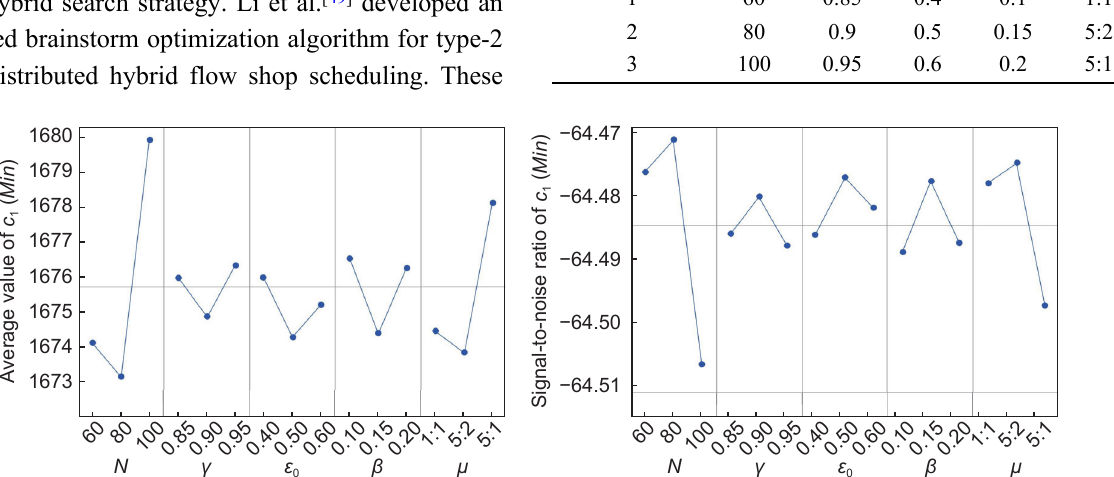
c 1 Min Fig. 4 Results on average value and S/N ratio on (